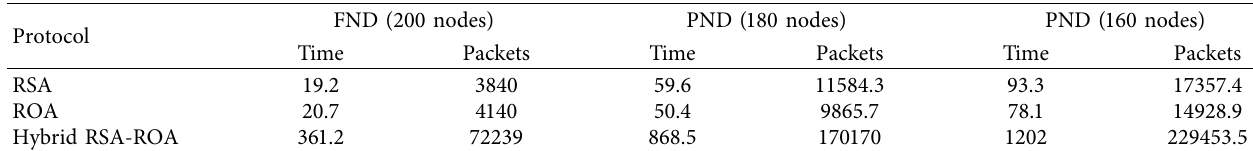
Table 6: Summary of FND and PND for proposed network 2.